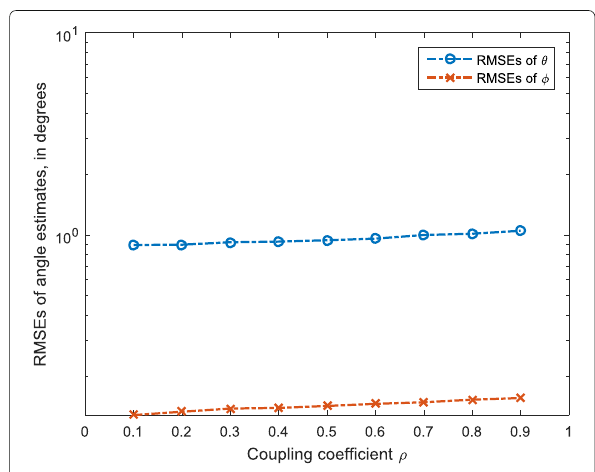
Fig. 6 RMSEs of θ and φ estimates versus coupling coefficient ρ .